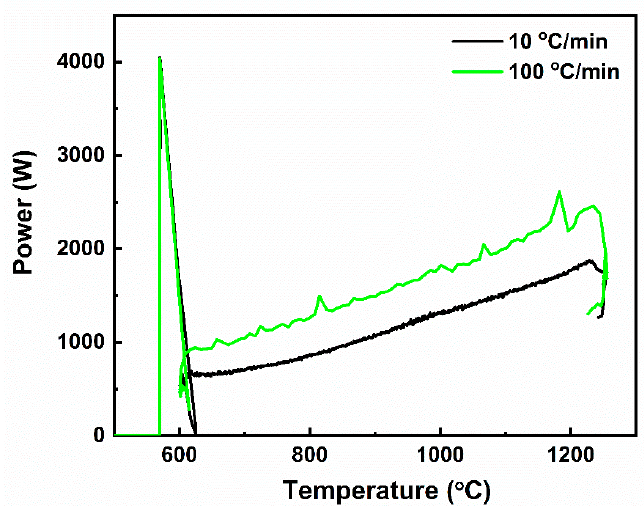
Figure 7. Heating rate dependent DC power during the SPS processing of the Y 2 O 3 ceramics at 10 and 100 °C/min.